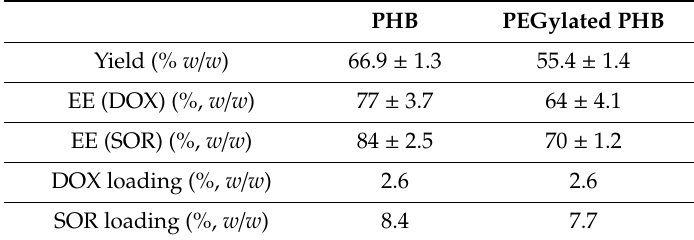
Table 1. Yield, encapsulation efficiency (EE), doxorubicin (DOX) and sorafenib (SOR) loading of dual drug-loaded poly(3-hydroxybutyrate) (PHB) and PEGylated poly(3-hydroxybutyrate) (PEGylated PHB) nanoparticles.